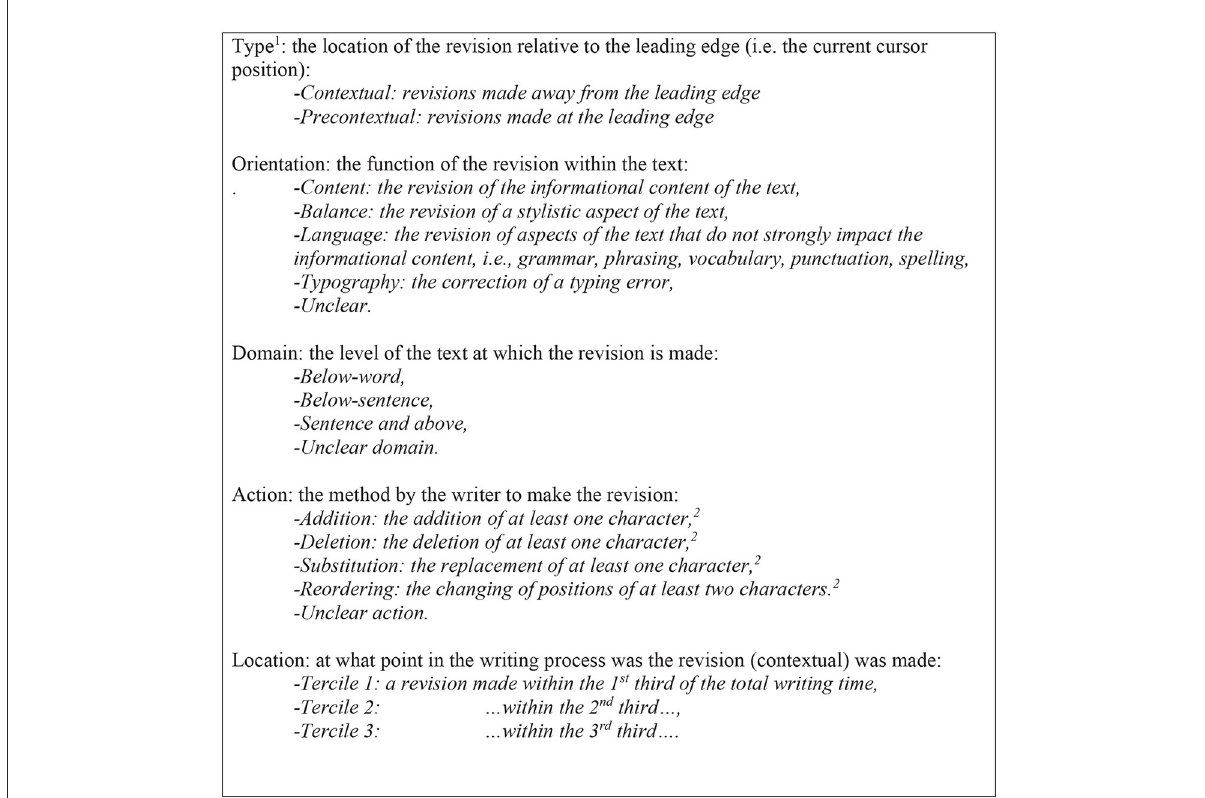
FIGURE1 Taxonomy of revisions—adapted from Barkaoui (2016). 1 Barkaoui (2016) has an additional coding scheme for contextual revisions. We did not categorize and analyze contextual revisions as our focus was on changes in higher-level revision behaviors. 2 In Barkaoui’s (2016) scheme the action class refers to changes made at the whole word level and above. In our scheme any addition , deletion , substitution or reordering is considered an action as it was more logically consistent that each contextual revision has a prescribed function (orientation), level of text (domain) and method